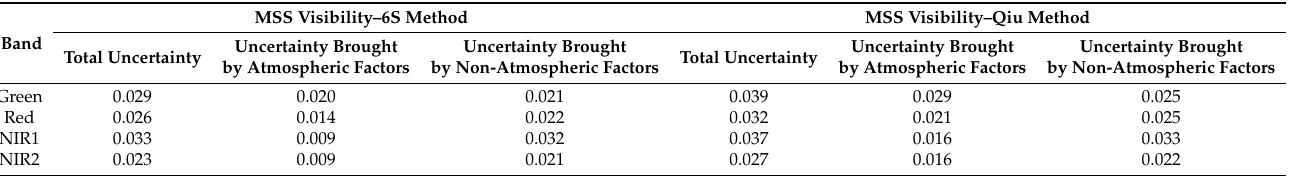
Table 5. Uncertainty sources of surface reflectance by visibility–6S method and visibility–Qiu